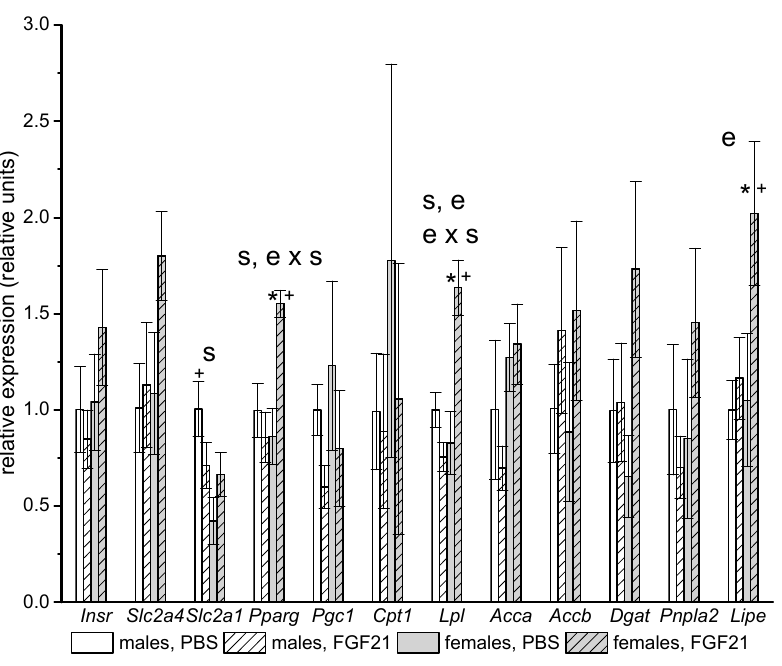
Figure 5. Influence of FGF21 administration on gene expression in abdominal WAT in male and female obese mice. Data are presented as mean ± SEM. Mice were administered FGF21 for 7 days. Significant influences of factor “e” (administration of PBS or FGF21), “s” (sex), and “e × s”, two-way ANOVA, are indicated in the plot. There were no sex differences in the expression of genes measured in the muscles ( Cpt1 , Slc2a4 , Pgc1a, Ucp1 , Ucp3 , and Lipe ). FGF21 administration did not affect the expression of these genes in the muscles. There were no significant sex differences in hypothalamic gene expression. FGF21 administration decreased the gene expression of the orexigenic neuropeptide Agouti- related protein ( Agrp) in both males and females (Figure 6).